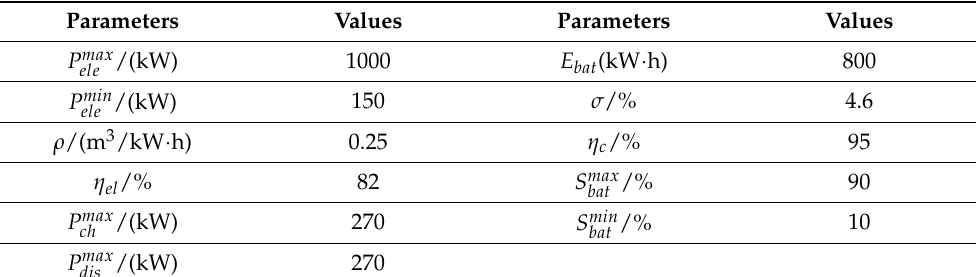
Table 3. Values of other